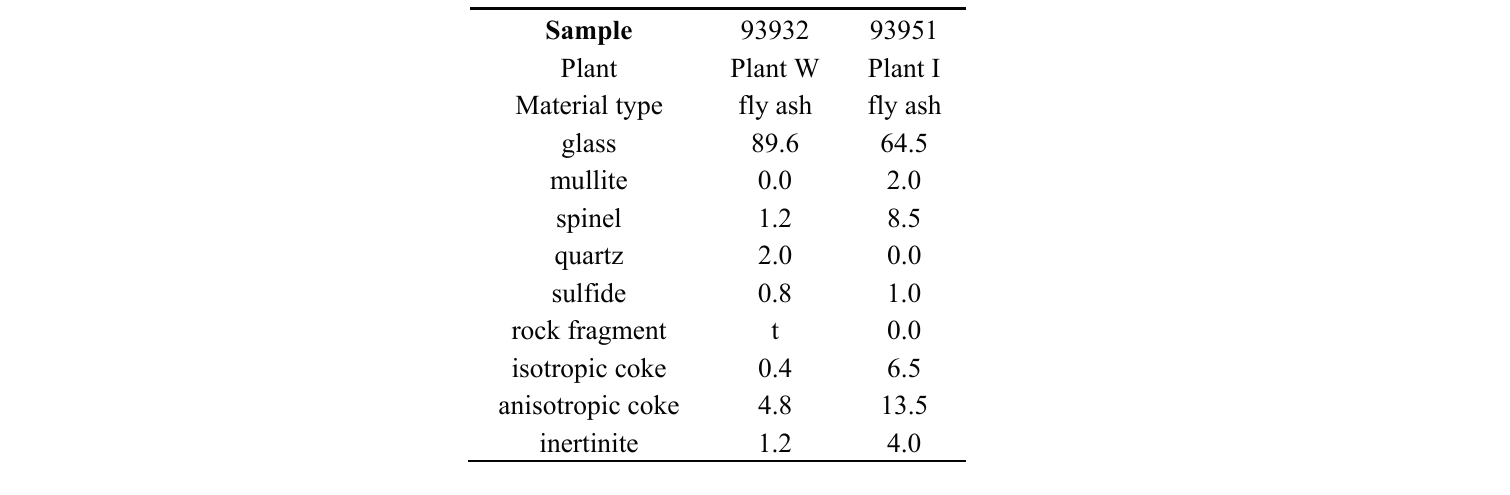
Table 4. Fly ash petrology (volume percent; t =